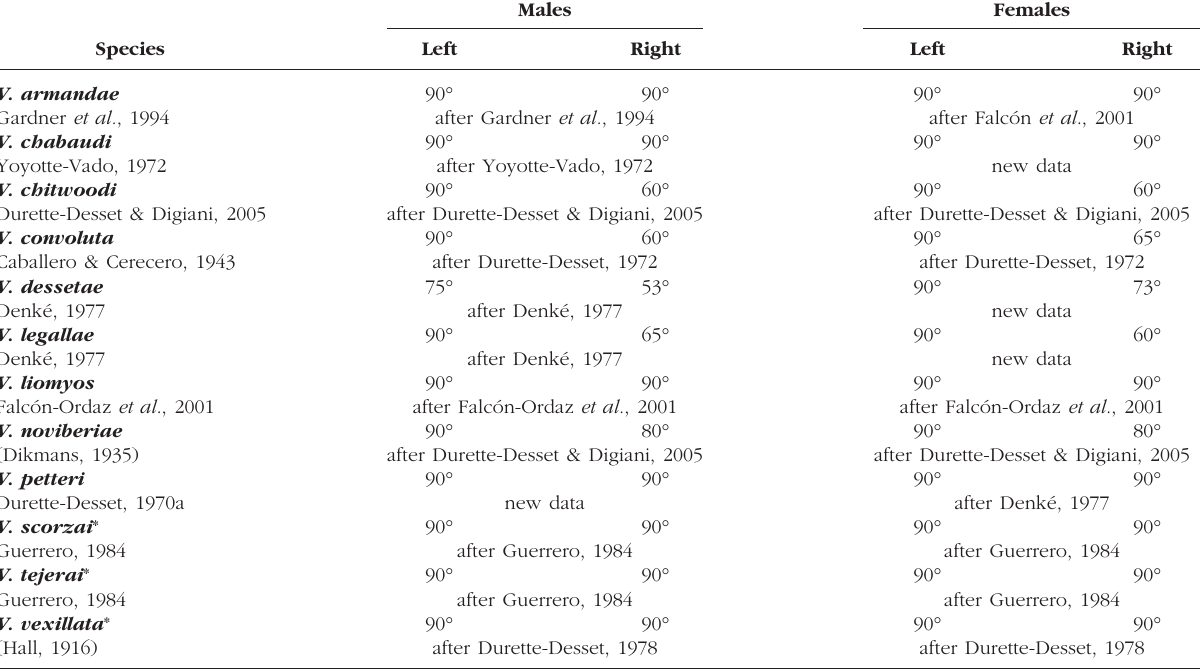
lest. Single axis of orientation directed from right to left and inclined at 90° to sagittal axis. Vexillata dessetae , female (Fig. 1B) - 12 cuticular ridges: two left forming carene, five dorsal, five ventral of inequal size and without gradient of size. Carene stron- gly developed. Ventral ridge adjacent to right lateral field smallest. Double axis of orientation directed from right ventral quadrant to the left; right axis inclined at 73° to sagittal axis and left axis at 90°. Vexillata legallae , female (Fig. 1C) - 12 cuticular ridges: two left forming carene, five dorsal, five ventral. Carene most developed and ventral ridge adjacent to right lateral field, smallest. All other ridges with